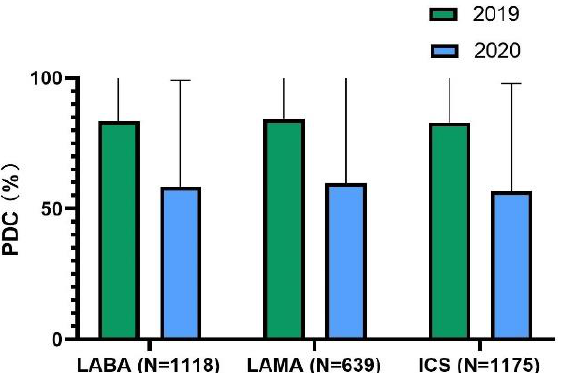
Figure 1. Proportion of individuals with high adherence to their controllers. Abbreviations: LABA, long- acting β2 -agonists; LAMA, long-acting muscarinic antagonists; ICS, inhaled corticosteroid.